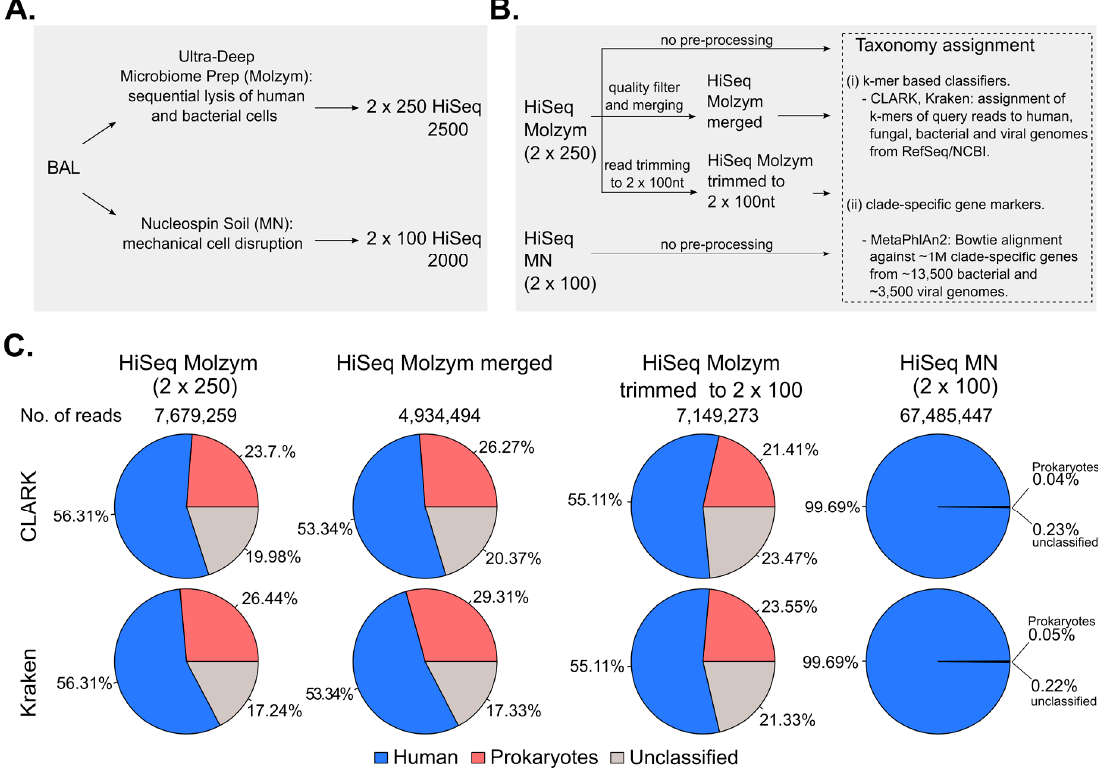
Figure 1. ( A ) Schematic representation of metagenomic sequencing: BAL was split into two aliquots which were independently treated with two DNA extraction protocols: Ultra-Deep Microbiome Prep (Molzym) and NucleoSpin Soil (MN). Metagenomic libraries were independently sequenced with 2 × 250 HiSeq 2500 and 2 × 100 Hiseq 2000, respectively; ( B ) Schematic representation of bioinformatics analyses: forward and reverse raw reads of Molzym- (HiSeq Molzym (2 × 250)) and MN-treated (HiSeq MN (2 × 100)) samples were used for taxonomic analysis with CLARK, Kraken and MetaPhlAn2. In addition, before taxonomic analyses, read pairs of the HiSeq Molzym (2 × 250) dataset were either quality-filtered and merged (HiSeq Molzym merged) or trimmed to the length of 100 nt (HiSeq Molzym trimmed to 2 × 100) as described in Materials and Methods; ( C ) Pie-charts representing the proportions (%) of sequencing reads classified as human (in blue), prokaryotic (red) or unclassified (grey) by CLARK (top row) and Kraken (bottom row). Proportions were computed over the total number of reads present in a given dataset. Viral- and fungal-classified read proportions are not shown and contributed to less 0.02% of total reads in all sequencing datasets.